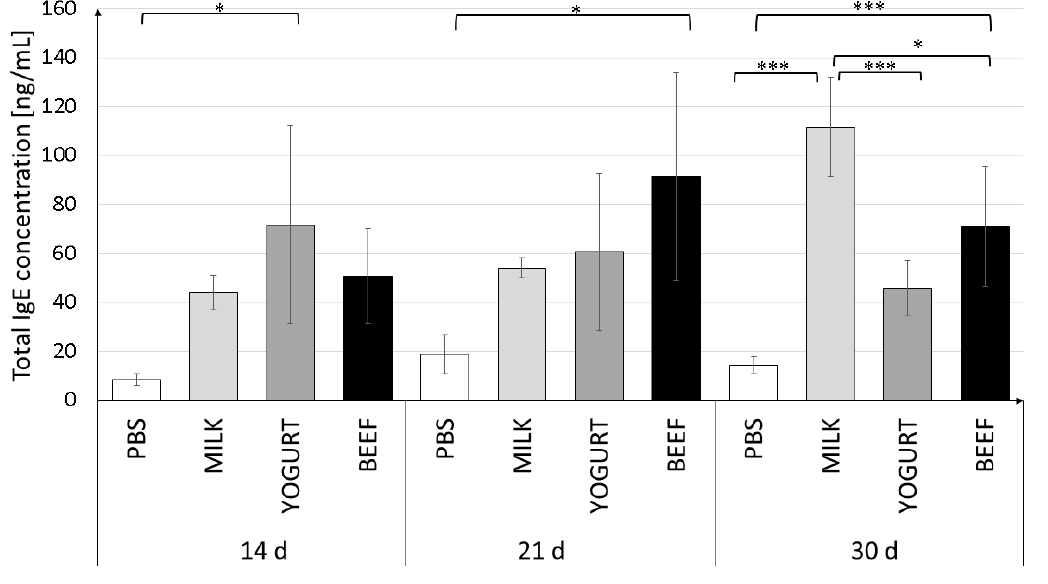
Figure 2. Total serum IgE levels in mice on days 14, 21, and 30 of the experiment. Mice were divided into four treatment groups ( n = 10): Mice in the Milk and Yogurt groups were immunized with α-CN/β-lg and fed milk or yogurt, respectively. Mice in the Beef group were immunized with BSA and fed beef meat. Mice in the PBS group were administered PBS. Data are the mean ± SD. * p < 0.05, *** p < 0.001, one-way ANOVA with Tukey post-hoc tests.